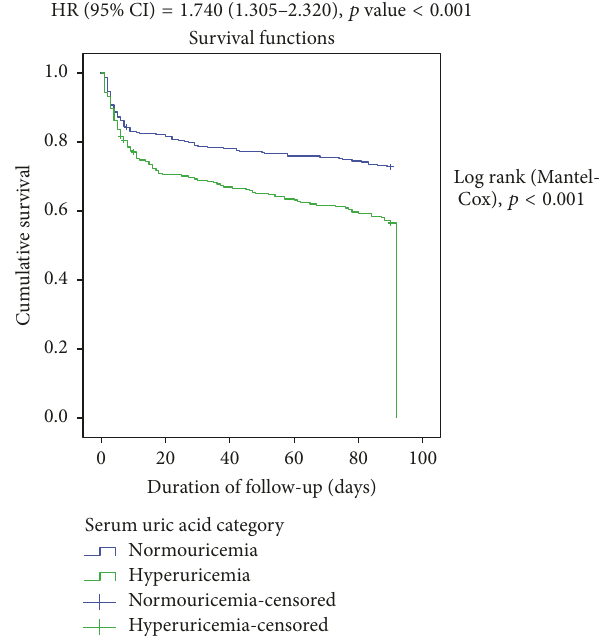
Figure 3: A graph showing a Kaplan-Meier survival rate of patients with normouricemia compared with hyperuricemia after an acute